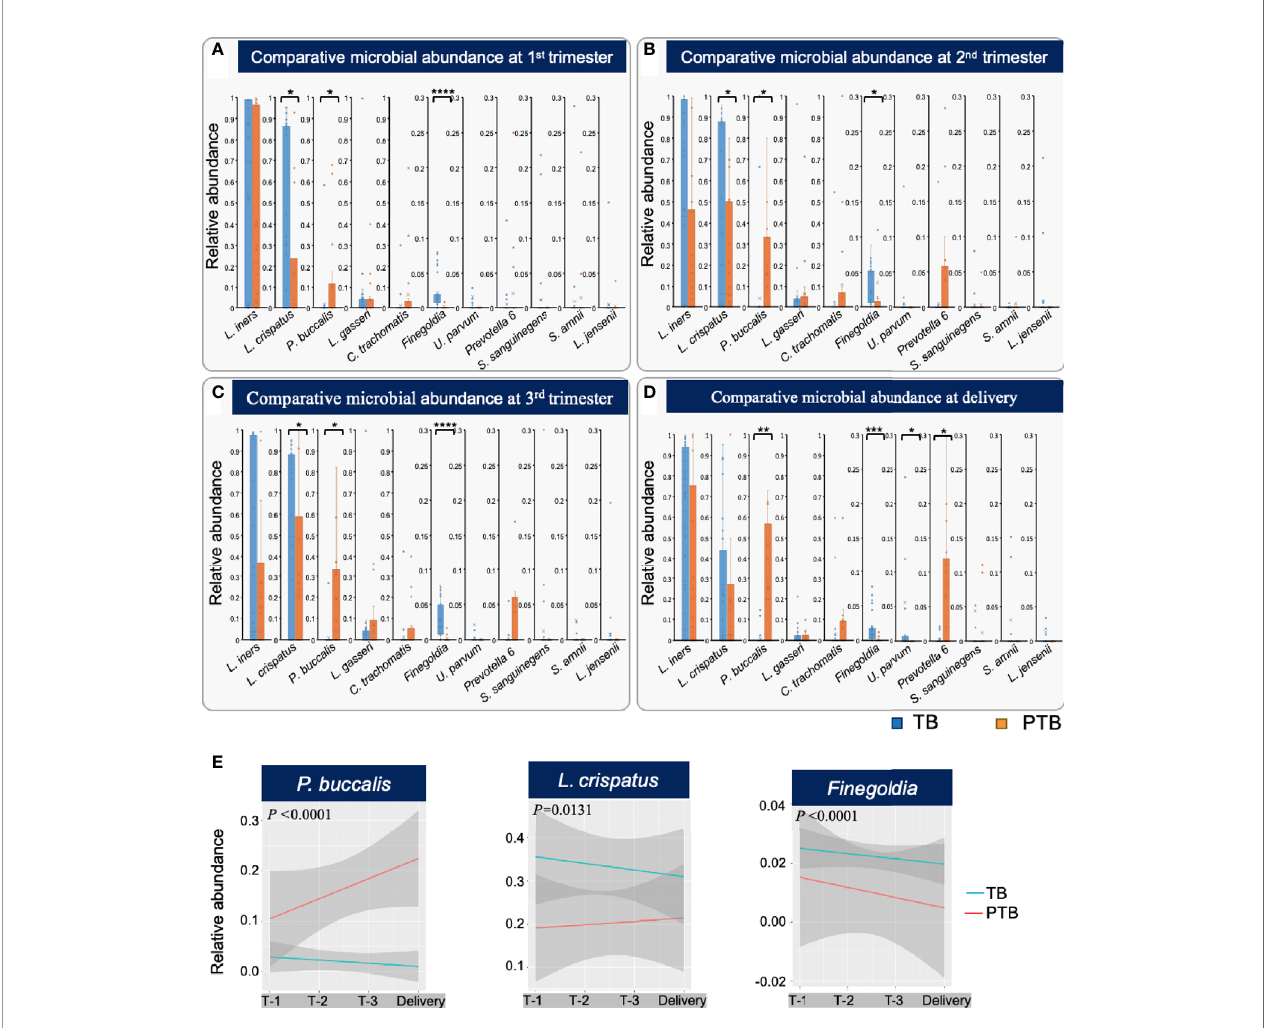
FIGURE 6 | Different bacterial taxa associated with TB and PTB. (A) Differences in relative abundance of the top 11 microbial taxa found between full term birth (TB) and preterm birth (PTB) groups in the fi rst trimester; (B) second trimester; (C) third trimester, and (D) at the time of delivery. Blue bars represent the TB group, while orange bars represent PTB. The asterisks indicate a signi fi cant difference between two groups (* P < 0.05, ** P < 0.01, *** P < 0.001, **** P < 0.0001). (E) Longitudinal trends in relative abundance of the statistically signi fi cant microbial taxa identi fi ed by comparing TB and PTB groups, analyzed using ggplots. Blue lines represent the TB group and red lines the PTB group. The P- values were calculated using the unpaired t -test (two-tailed) with Welch ’ s correction for difference in proportional microbial abundance between TB and PTB